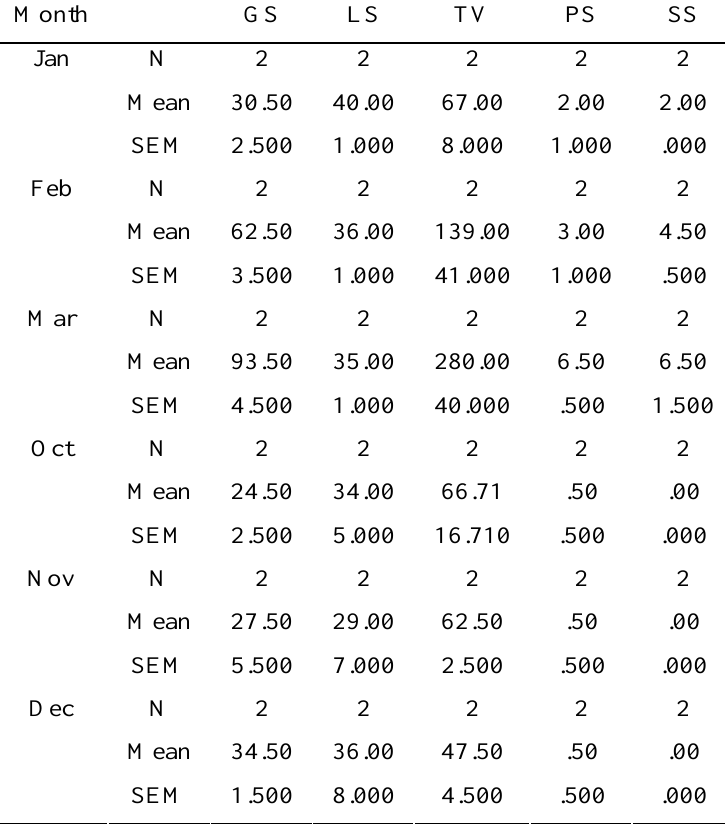
Table 1. Descriptive statistics of five characters during hibernation period (Abbreviations are shown in material and methods). N= Number, SEM= Standard Error of